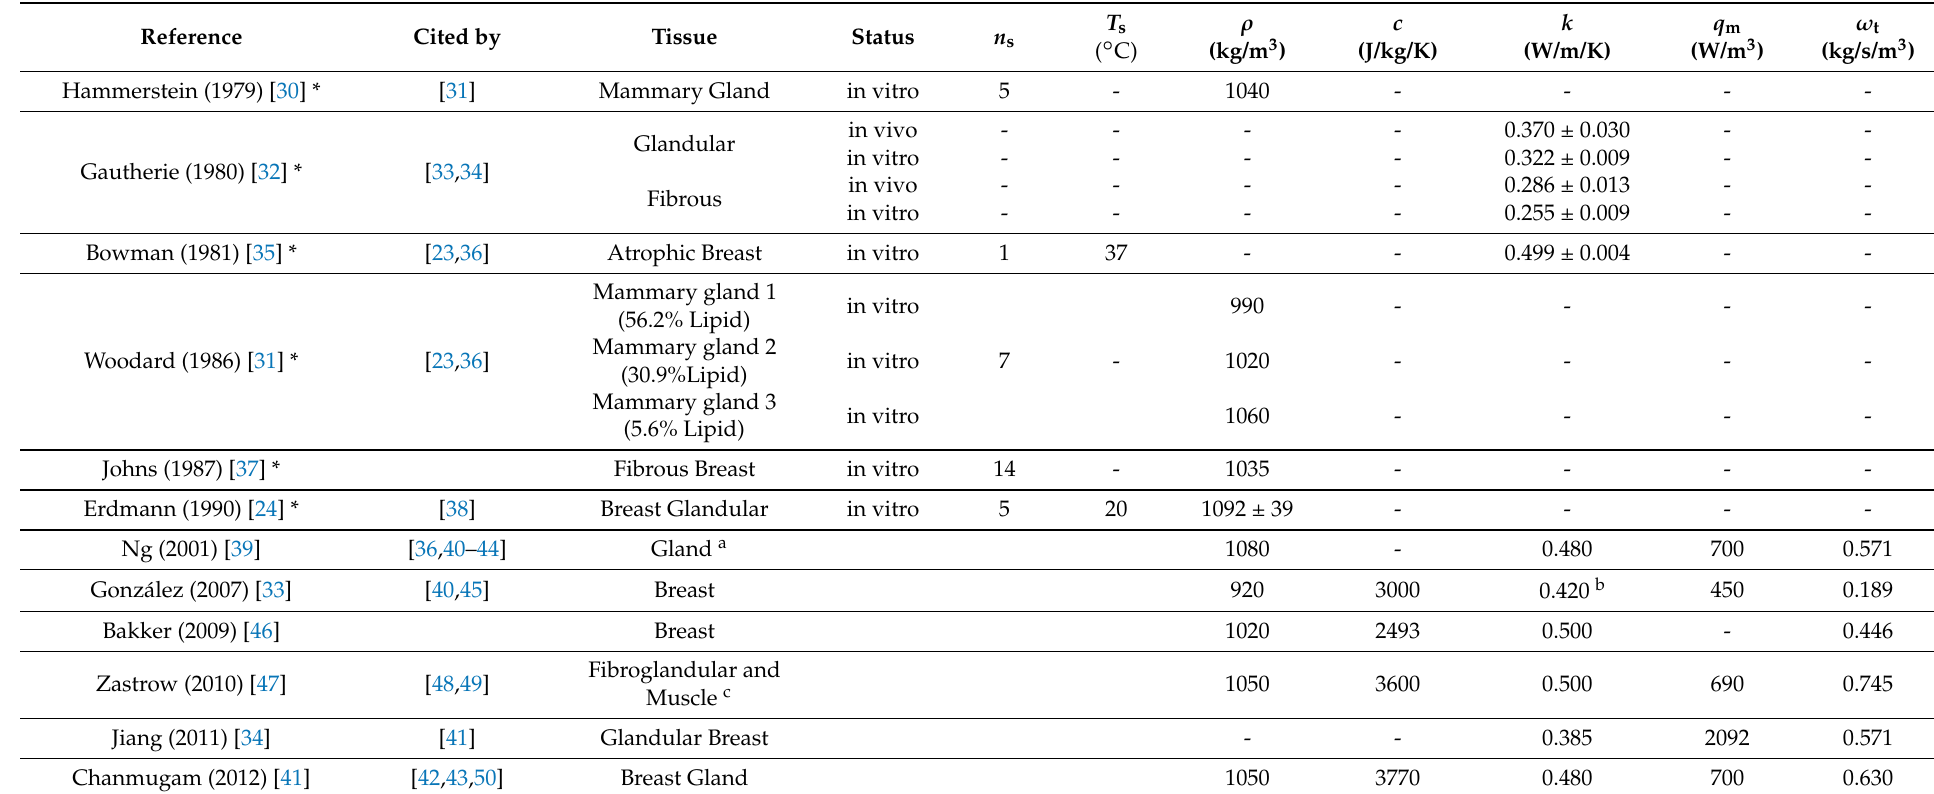
Table 3. The thermal and physiological properties of human fibroglandular breast